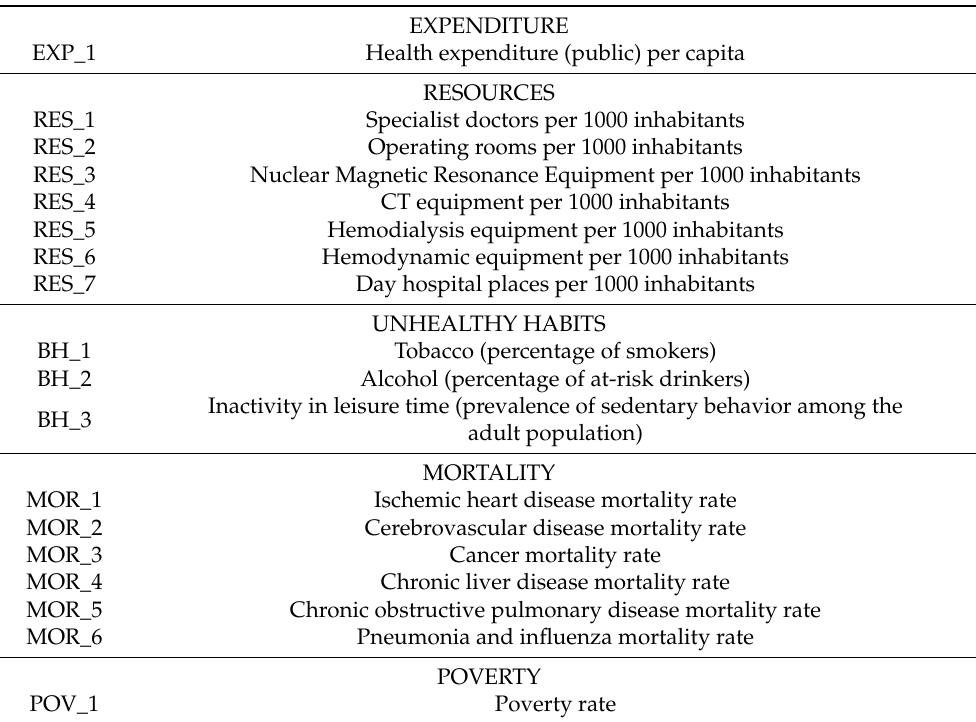
Table 1. Measurement